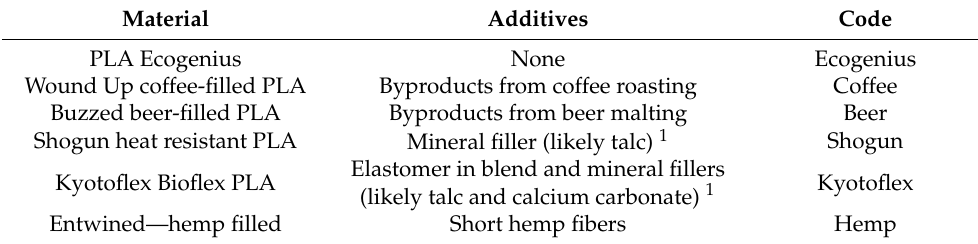
Table 1. Commercial names, additives, and codes of all investigated PLA-based